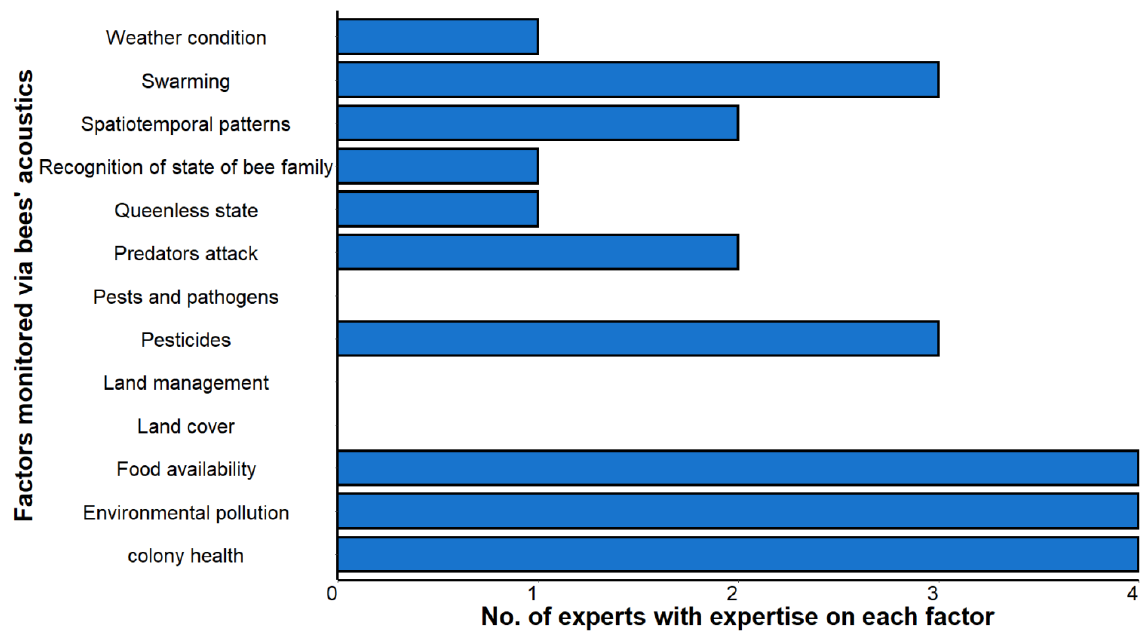
Figure 3. This figure represents the number of participating experts who have volunteered